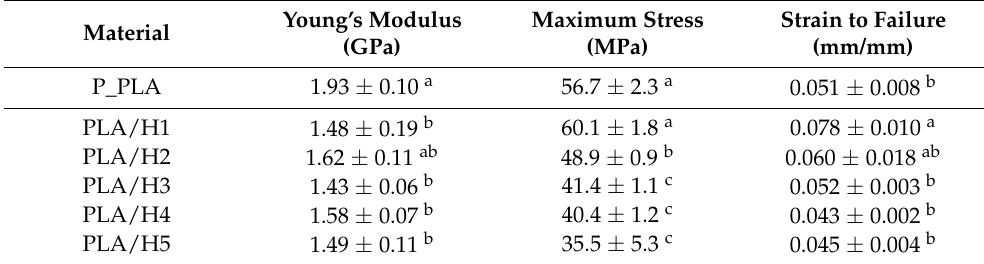
Table 4. Tensile mechanical properties of 3D printed PLA and